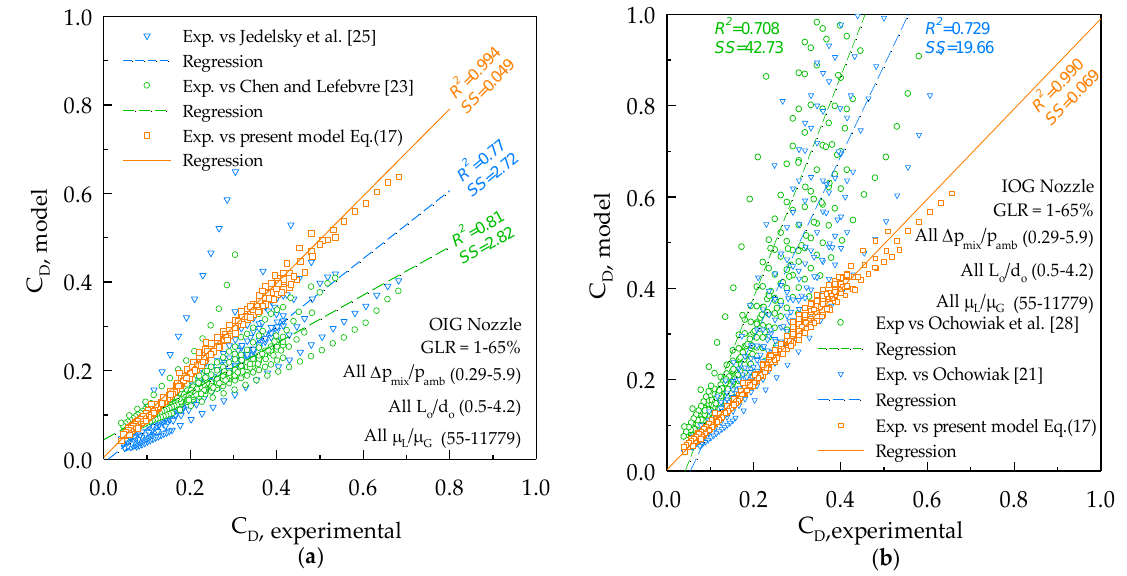
Figure 14. Comparison of the experiments and published models for ( a ) the OIG nozzle and ( b ) the IOG nozzle.